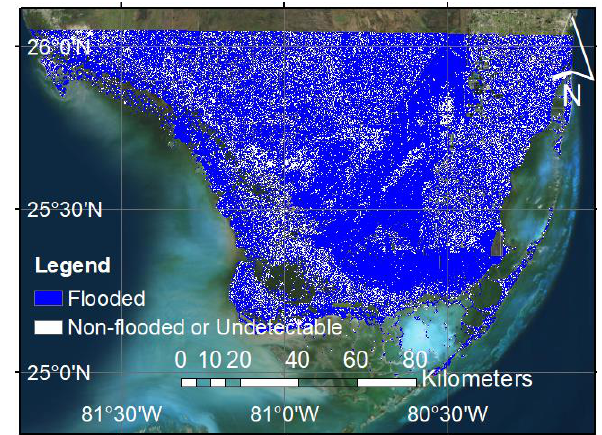
Figure 7. Binary map showing the extent of flooding induced by hurricane Irma. Blue indicates all the flooded areas, which is the sum of flooding area in Figure 5. White color indicates nonflooded or undetectable